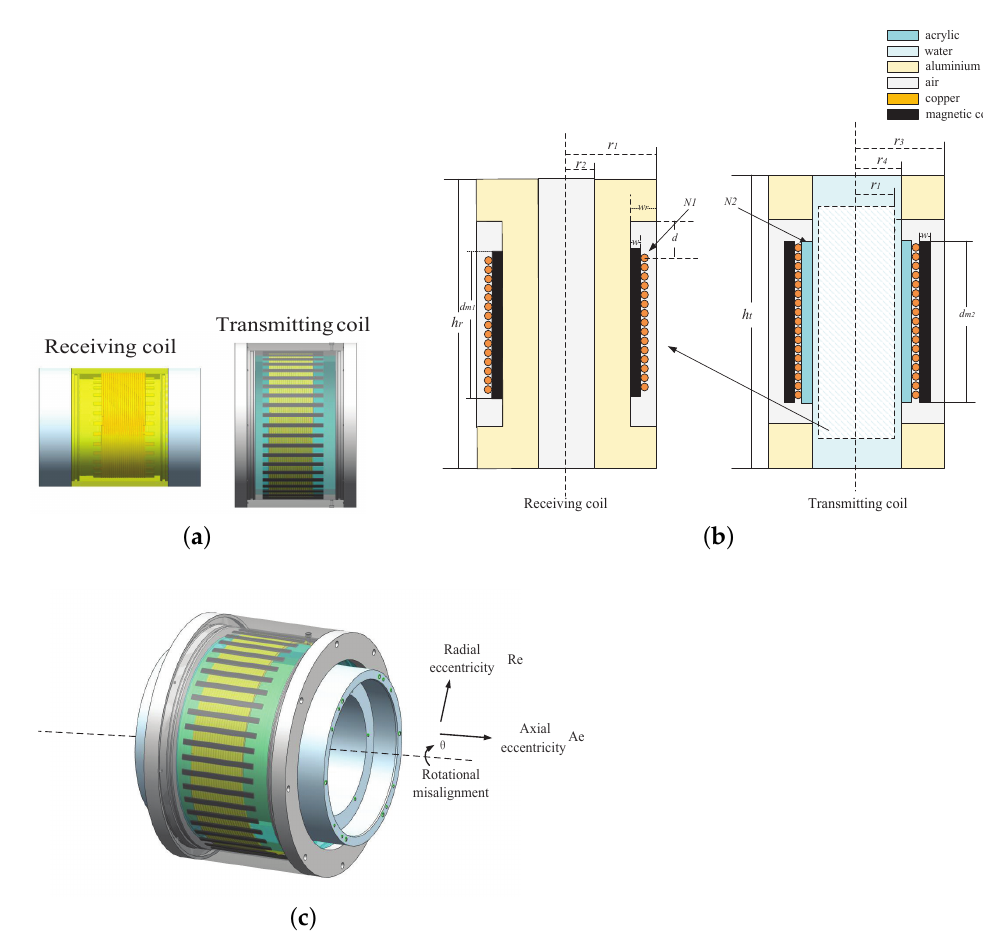
Figure 2. ( a ) Schematic diagram of the coil structure. ( b ) Simulation model of the coil structure. ( c ) The definition of the